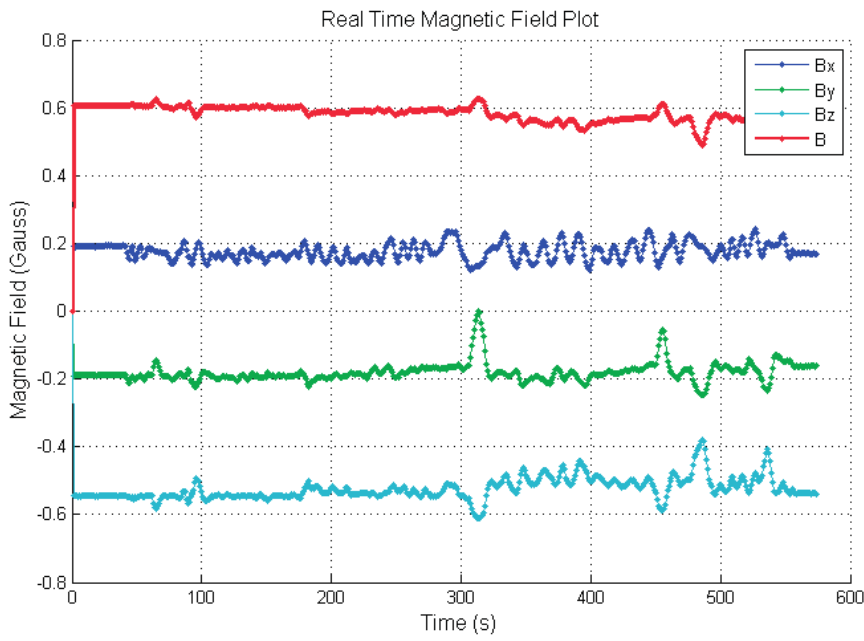
Figure 9. Uncalibrated sensor